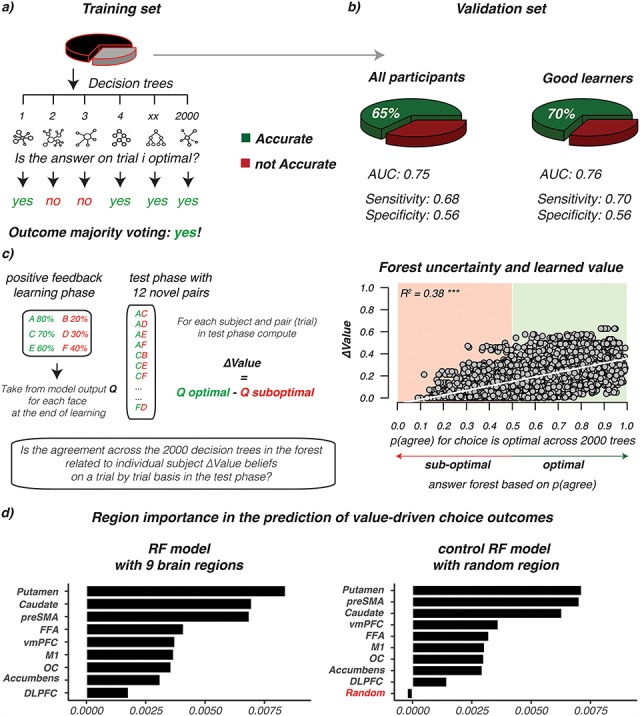
Random Forest performance and importance ranking. Prediction of value-driven choice outcomes in the transfer phase using trial-by-trial BOLD responses from striatal, perceptual, and prefrontal cortex regions. (a) Overview of the Random Forest approach where the training set is used to predict choice outcomes for each trial by using the majority vote of 2000 different decision trees. Each tree is built using a different set, or sample, of trials and predictors from the training set. The forest is trained on a training set sampled from all participants (N = 43) or only “the good learners” (N = 34). (b) The classification, or decoding, accuracy (green) given the separate unseen validation sets, for all participants and good learners. (c) On the left, overview of the feedback scheme in the learning phase, and the new combination in transfer about which the RF is making a prediction with an illustration of how \documentclass[12pt]{minimal}
\usepackage{amsmath}
\usepackage{wasysym} 
\usepackage{amsfonts} 
\usepackage{amssymb} 
\usepackage{amsbsy}
\usepackage{upgreek}
\usepackage{mathrsfs}
\setlength{\oddsidemargin}{-69pt}
\begin{document}
}{}$\varDelta$\end{document}Value is computed for each trial. \documentclass[12pt]{minimal}
\usepackage{amsmath}
\usepackage{wasysym} 
\usepackage{amsfonts} 
\usepackage{amssymb} 
\usepackage{amsbsy}
\usepackage{upgreek}
\usepackage{mathrsfs}
\setlength{\oddsidemargin}{-69pt}
\begin{document}
}{}$\varDelta$\end{document}Value was computed for each trial in the transfer phase by using the end beliefs (\documentclass[12pt]{minimal}
\usepackage{amsmath}
\usepackage{wasysym} 
\usepackage{amsfonts} 
\usepackage{amssymb} 
\usepackage{amsbsy}
\usepackage{upgreek}
\usepackage{mathrsfs}
\setlength{\oddsidemargin}{-69pt}
\begin{document}
}{}$Q$\end{document}) that participants had about each stimulus (A-to-F) at the end of the learning phase. On the right side, plotted relationship between forest uncertainty (i.e., proportion of agreement across 2000 trees) on each prediction/trial (x-axis) and \documentclass[12pt]{minimal}
\usepackage{amsmath}
\usepackage{wasysym} 
\usepackage{amsfonts} 
\usepackage{amssymb} 
\usepackage{amsbsy}
\usepackage{upgreek}
\usepackage{mathrsfs}
\setlength{\oddsidemargin}{-69pt}
\begin{document}
}{}$\varDelta$\end{document}Value (y-axis) for the model with the highest accuracy (i.e., the good learners). Forest uncertainty is defined as the proportion of trees saying “yes! the choice on this trial was optimal/correct.” When this ratio is below 0.5, the forest will predict “no” (suboptimal/wrong choice), otherwise the prediction is “yes! the choice on this trial was optimal/correct” (optimal). \documentclass[12pt]{minimal}
\usepackage{amsmath}
\usepackage{wasysym} 
\usepackage{amsfonts} 
\usepackage{amssymb} 
\usepackage{amsbsy}
\usepackage{upgreek}
\usepackage{mathrsfs}
\setlength{\oddsidemargin}{-69pt}
\begin{document}
}{}${R}^2$\end{document}=adjusted \documentclass[12pt]{minimal}
\usepackage{amsmath}
\usepackage{wasysym} 
\usepackage{amsfonts} 
\usepackage{amssymb} 
\usepackage{amsbsy}
\usepackage{upgreek}
\usepackage{mathrsfs}
\setlength{\oddsidemargin}{-69pt}
\begin{document}
}{}${R}^2$\end{document}. Note that the same pattern was found for all participants (\documentclass[12pt]{minimal}
\usepackage{amsmath}
\usepackage{wasysym} 
\usepackage{amsfonts} 
\usepackage{amssymb} 
\usepackage{amsbsy}
\usepackage{upgreek}
\usepackage{mathrsfs}
\setlength{\oddsidemargin}{-69pt}
\begin{document}
}{}${R}^2={0.41}^{\ast \ast \ast }$\end{document}, please see Supplementary Fig. 3). (d) Ranking of the ROIs in their contribution to the predictive accuracy of the best performing model (i.e., good learners). Left, The original ranking. On the right, we evaluate ranking with all 9 original regions, but now add a control region that was sampled randomly from \documentclass[12pt]{minimal}
\usepackage{amsmath}
\usepackage{wasysym} 
\usepackage{amsfonts} 
\usepackage{amssymb} 
\usepackage{amsbsy}
\usepackage{upgreek}
\usepackage{mathrsfs}
\setlength{\oddsidemargin}{-69pt}
\begin{document}
}{}$\mathcal{N}\Big(0,1\Big)$\end{document}, and unrelated to the activity of any region, or \documentclass[12pt]{minimal}
\usepackage{amsmath}
\usepackage{wasysym} 
\usepackage{amsfonts} 
\usepackage{amssymb} 
\usepackage{amsbsy}
\usepackage{upgreek}
\usepackage{mathrsfs}
\setlength{\oddsidemargin}{-69pt}
\begin{document}
}{}$\varDelta$\end{document}Value. Notice that the random variable has negative importance in the ranking, meaning that removing it improves model performance with \documentclass[12pt]{minimal}
\usepackage{amsmath}
\usepackage{wasysym} 
\usepackage{amsfonts} 
\usepackage{amssymb} 
\usepackage{amsbsy}
\usepackage{upgreek}
\usepackage{mathrsfs}
\setlength{\oddsidemargin}{-69pt}
\begin{document}
}{}$0.5\%$\end{document}.